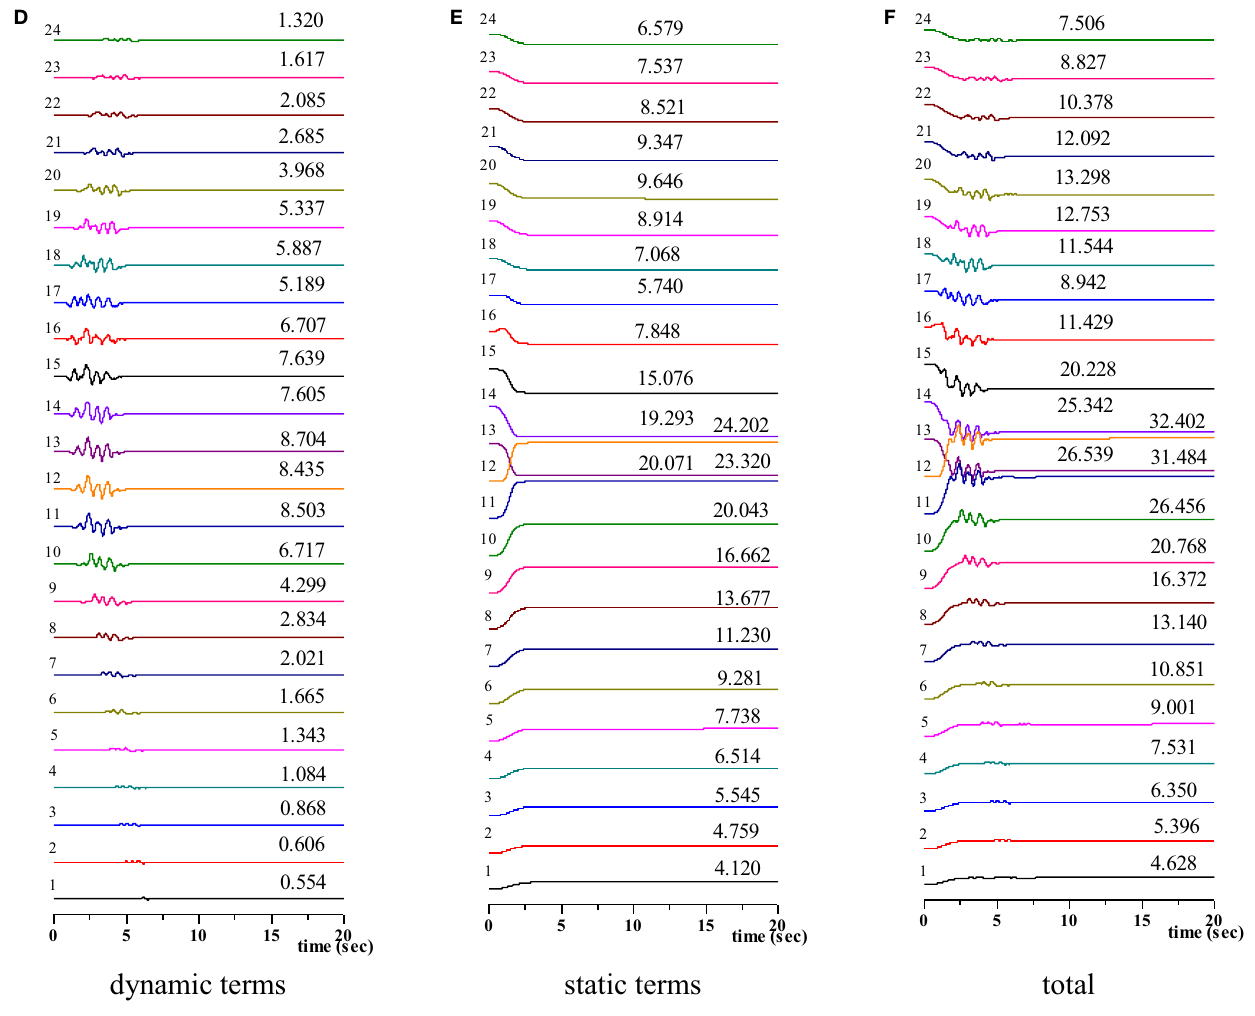
FigUre 10 | simulated time histories of velocity [(a) dynamic terms (B) static terms, (c) total] and displacement [(D) dynamic terms (e) static terms (F) total] along eW direction (note: the left numbers present the observation point, right numbers present the peak values)